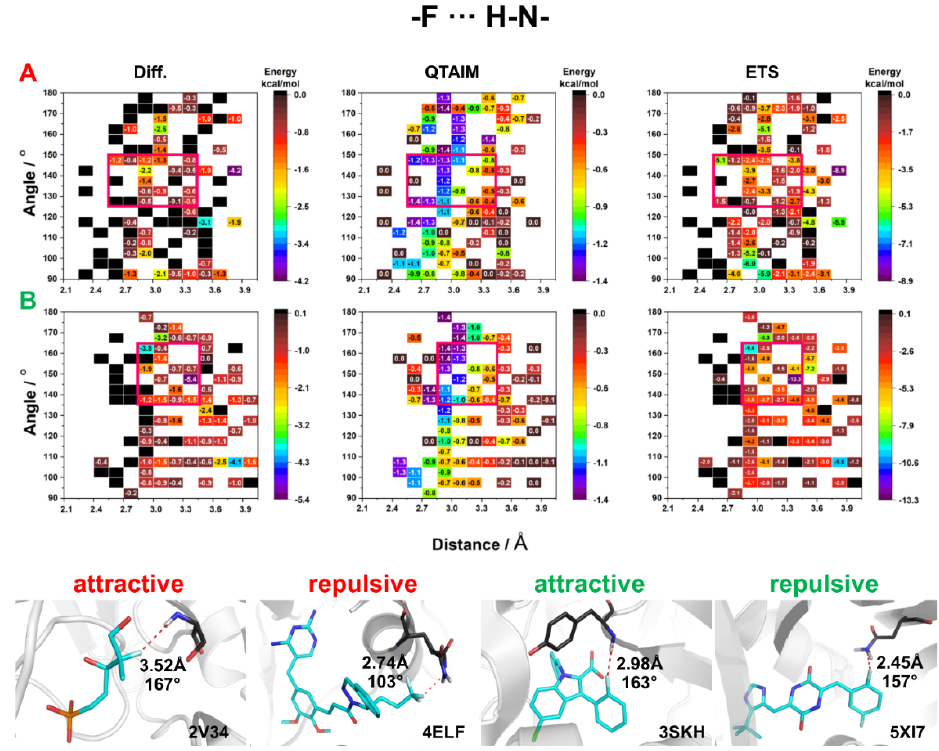
Figure 8. HB energy maps generated based on Diff, QTAIM, and ETS calculations of interaction energy between NH donor and fluorine attached to ( A ) an aliphatic fragment and ( B ) an aromatic ring for specific geometric parameters. The areas for which the highest stabilizing energy was observed in all three methods are marked with a red square.